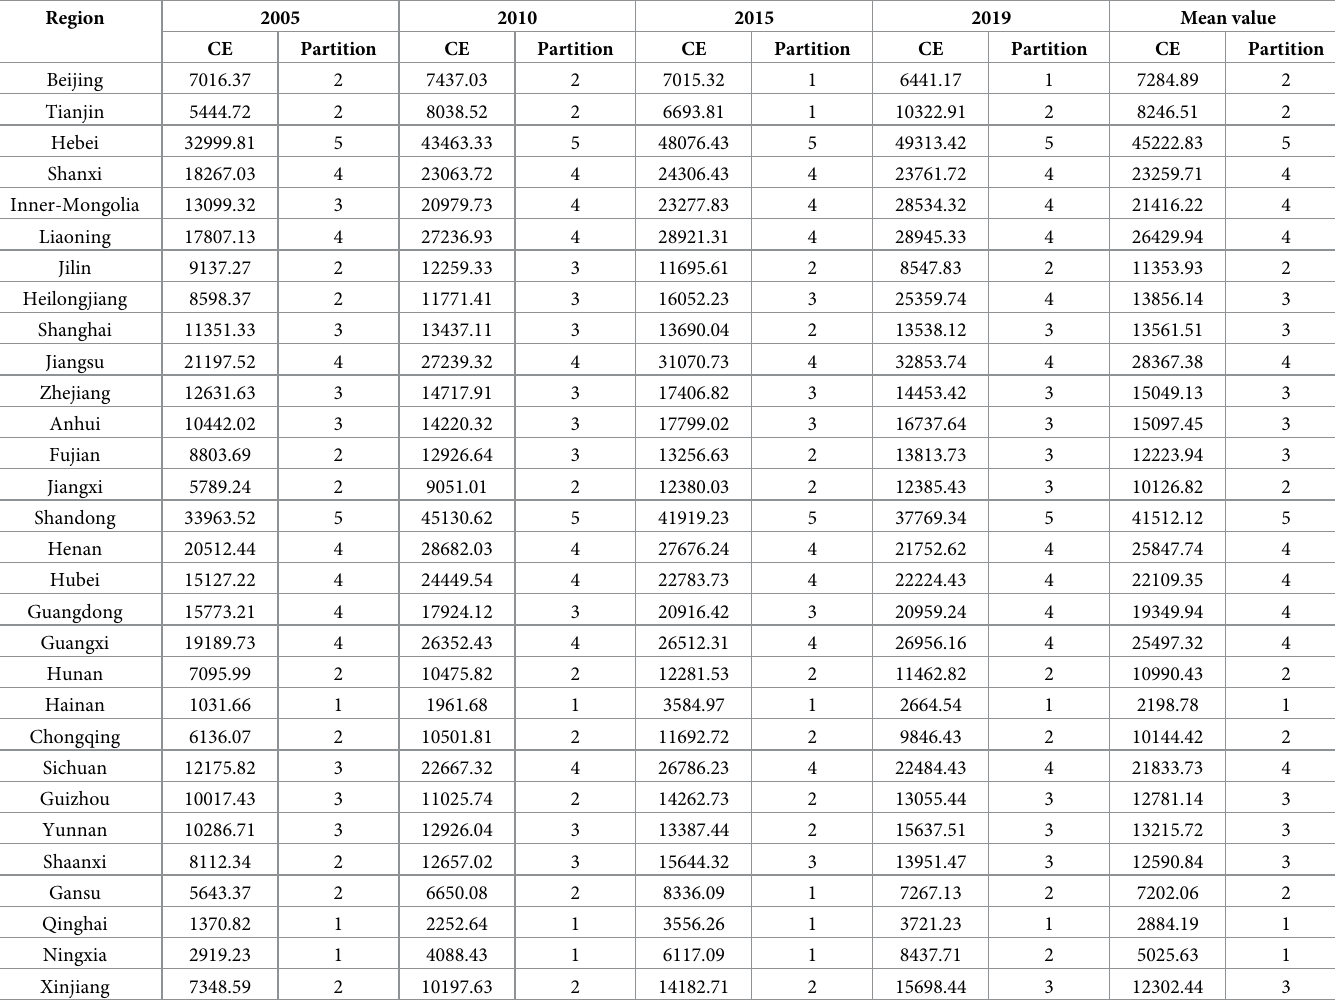
Table 2. Carbon emission estimation results of each province in 2005, 2010, 2015, and 2019. (Unit:10 4 t).